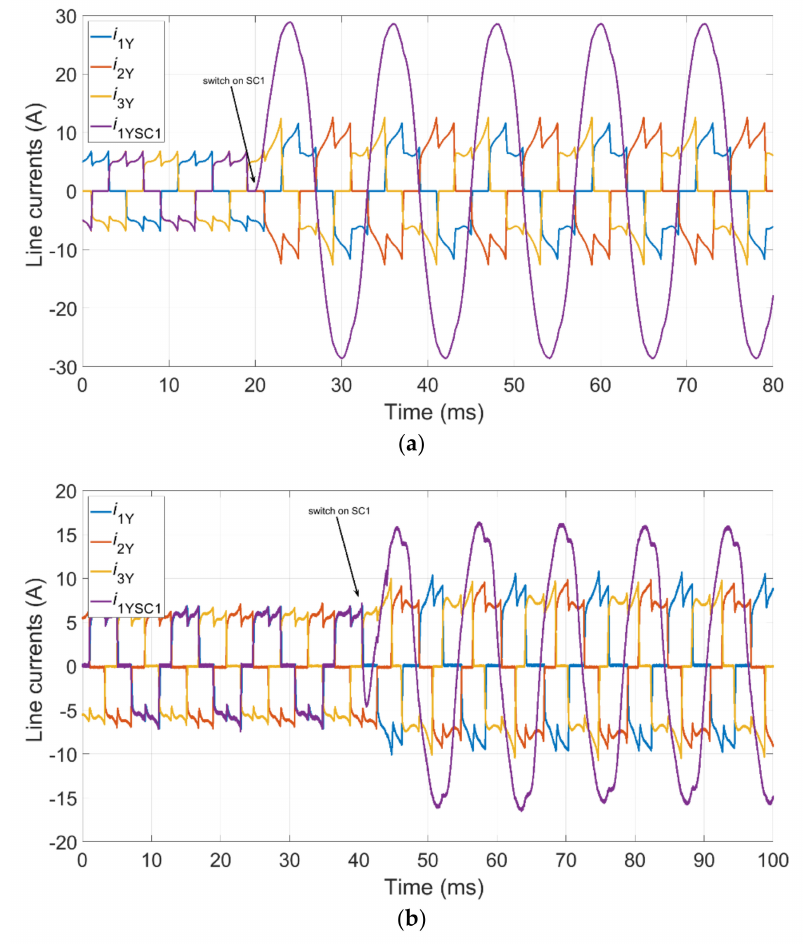
Figure 5. Y configuration -waveforms of line currents, healthy to SC1 ( a ) numerical calculations, ( b ) laboratory